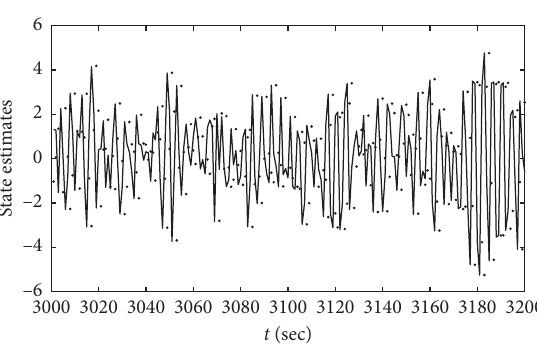
Figure 3: The state and state estimate 􏽢 x ( t ) ; dots: the estimated 􏽢 x true x 1